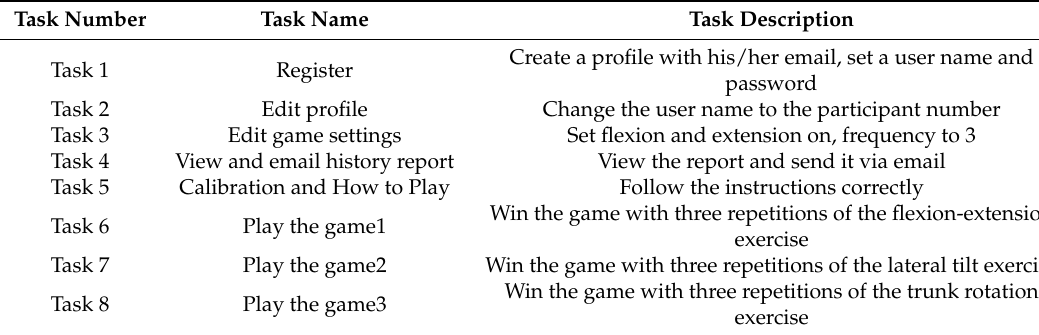
Figure 7. Evaluation process flowchart. T able 4. Evaluation tasks’ Description. Table 4. Evaluation tasks’